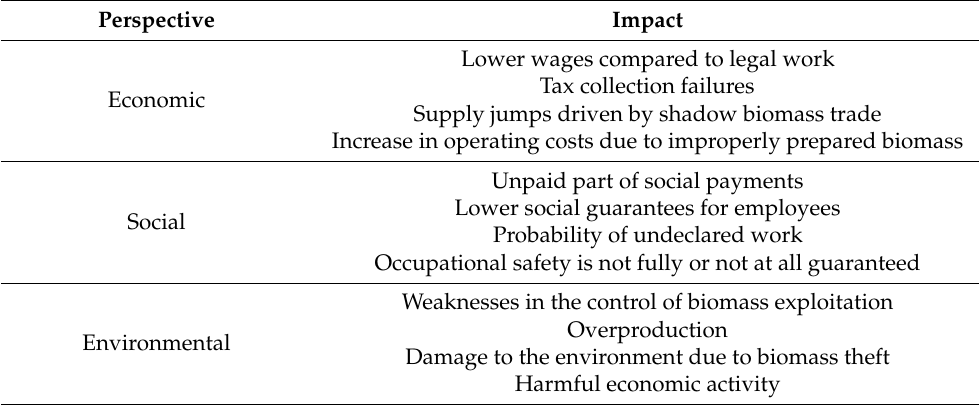
Table 1. Trends in the shadow economy in the aspect of sustainable